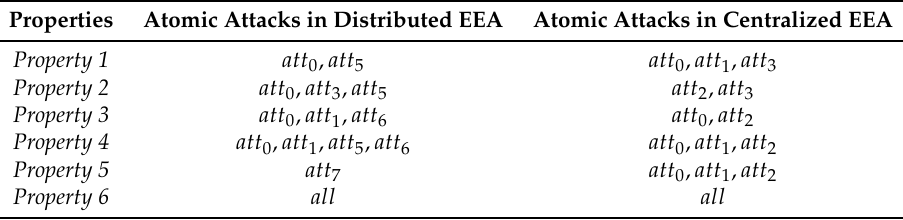
Table 5. Atomic attacks when attacker capability is 12.